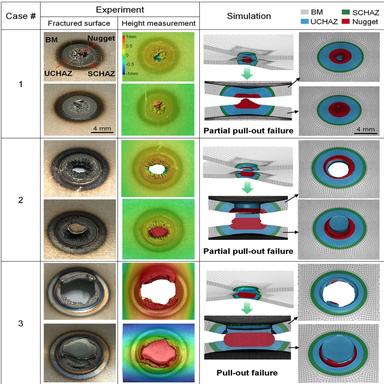
Cross-tension failure modes comparison between experiment and simulation.